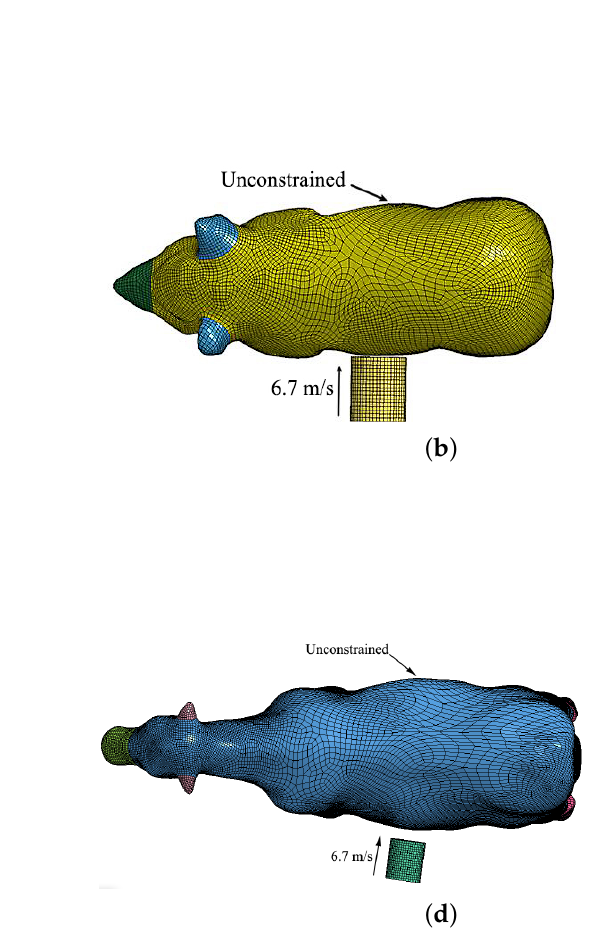
Figure 11. Simulation of pendulum side impact for laminated model: ( a ) Pig model side-impact model; ( b ) pig model simulation condition setting; ( c ) cow model side-impact model; ( d ) cow model simulation condition setting.